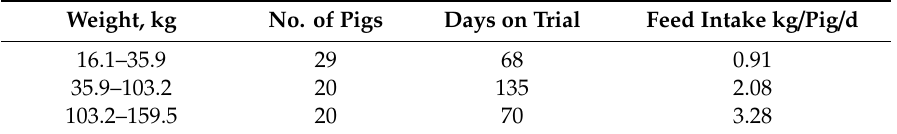
Table A6. Data on Iberian breed used for modelling [14] 1 .